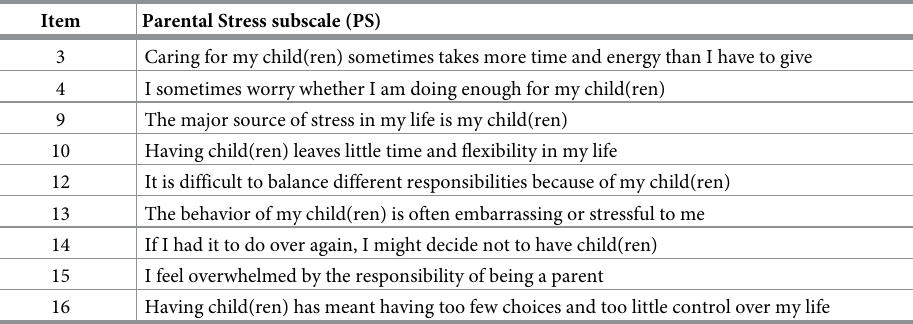
Table 2. The parental stress (PS) subscale of the PSS. Item